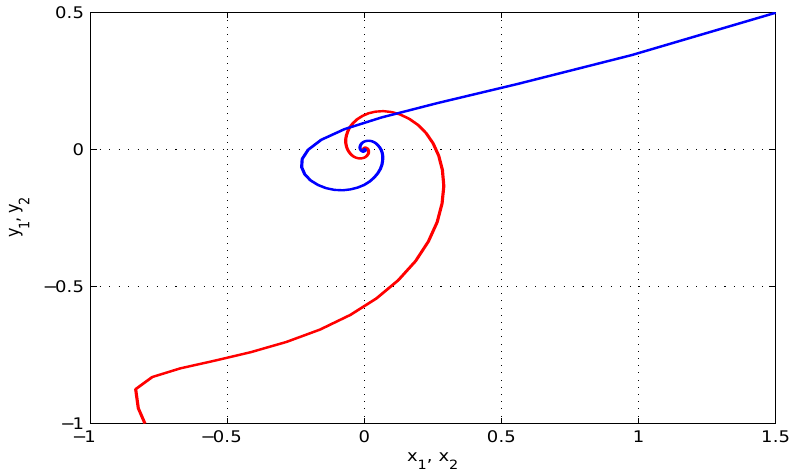
Figure 16. An illustration of the time responses between the real and imaginary subspace pertaining to the model in (13), in which ˜ u ( t ) = 0 in Example